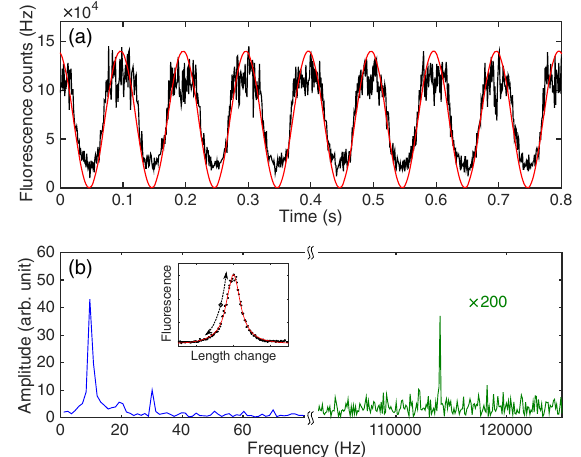
FIG. 6. (a) 00ZPL emission of a molecule as a function of the cavity length modulation at 10 Hz. (b) Fourier transform of the signal in (a), revealing the second and third harmonics of it (left) together with the Fourier transform of the signal from a cavity modulation at 114 kHz (right). The inset shows the region of the cavity resonance that is scanned. The highest frequency achieved in this experiment is limited by the resolution of our data acquisition